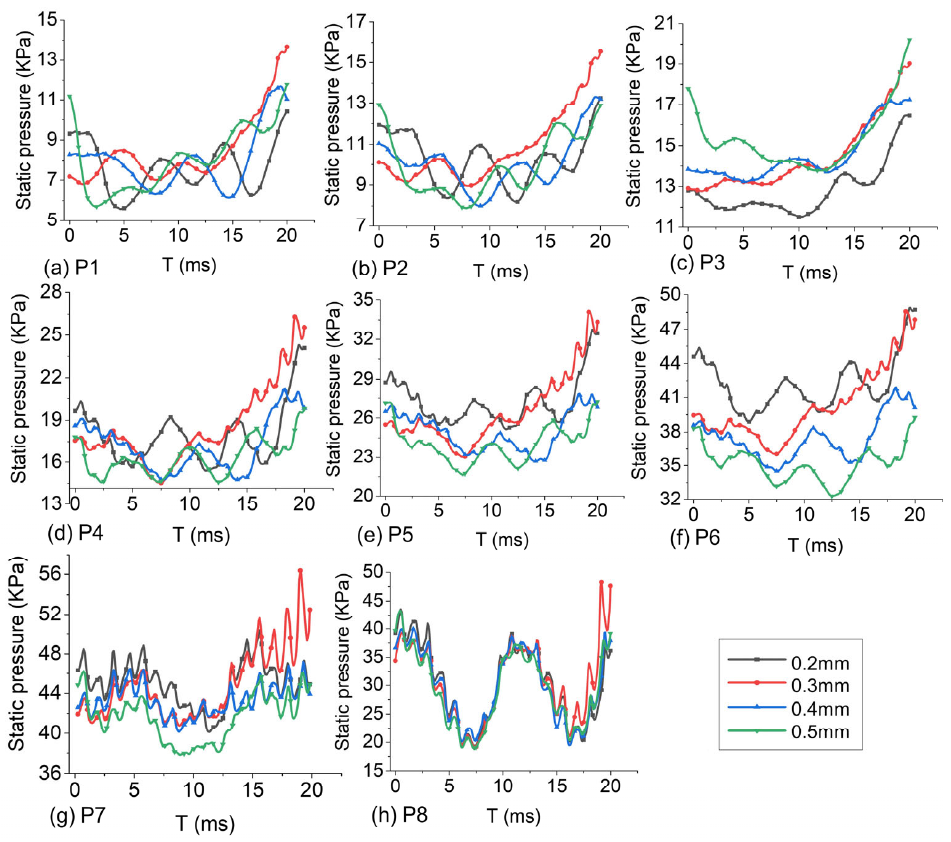
Figure 8. Static pressure change diagram of monitoring points: ( a ) P1, ( b ) P2, ( c ) P3, ( d ) P4, ( e ) P5, ( f ) P6, ( g ) P7 and ( h ) P8.